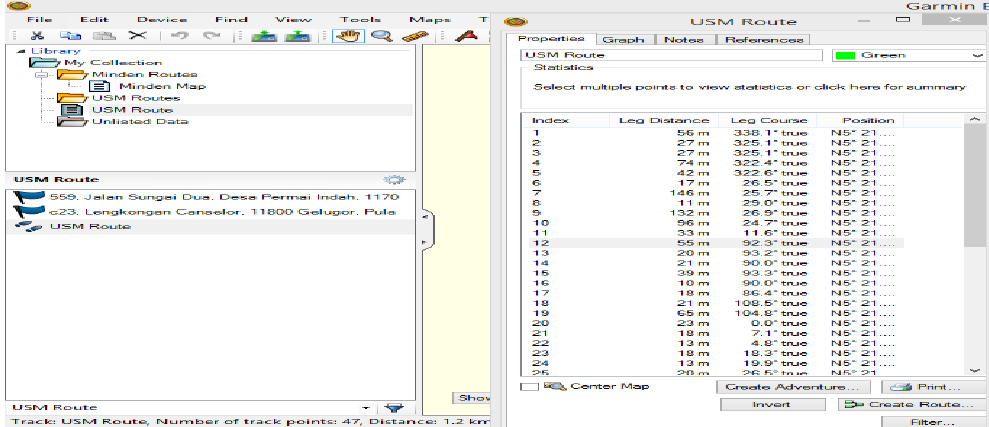
Figure 3. Obtaining the coordinates using Garmin